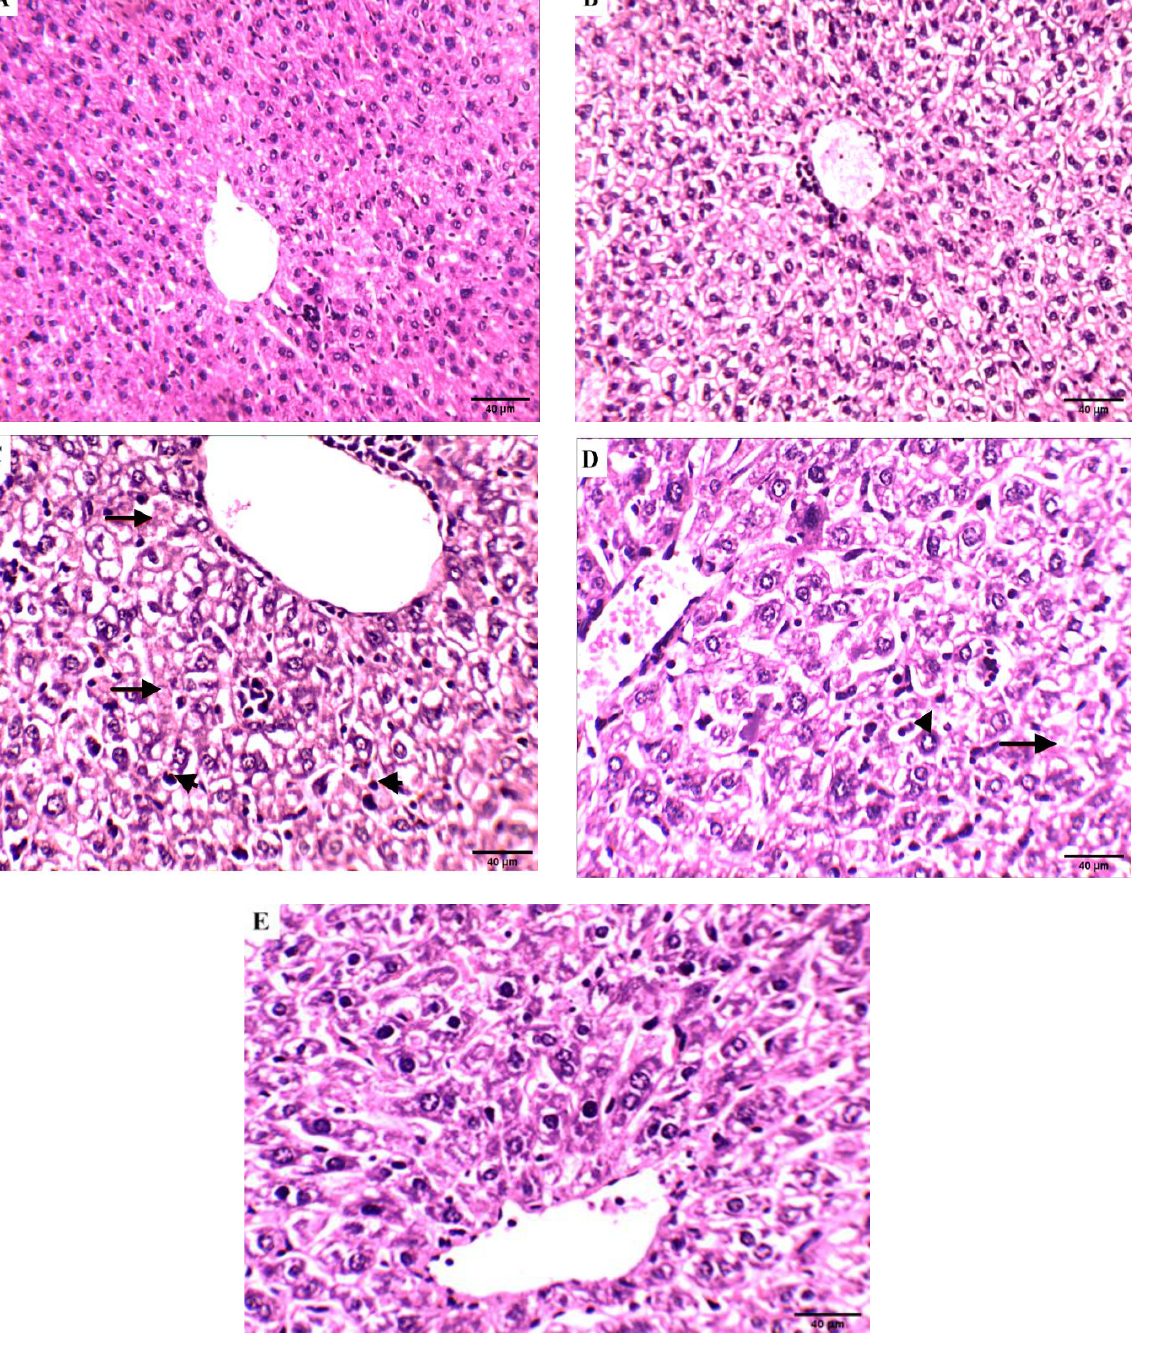
Figure 8. Effect of compound 4 on the liver tissue of SEC-bearing mice: ( A ) normal control, ( B ) normal group treated with compound 4. ( C ) SEC control group, shows nuclear pyknosis (arrowheads) and karyolysis (arrows). ( D ) SEC mice treated with 5-FU still exhibit hydropic degeneration of hepatocytes, nuclear pyknosis (arrowheads), and karyolysis (arrows). ( E ) SEC mice treated with compound 4 (H&E stains, magnification ×200). Quantification data of the H&E analysis of liver are supported in Supplementary Table S2.